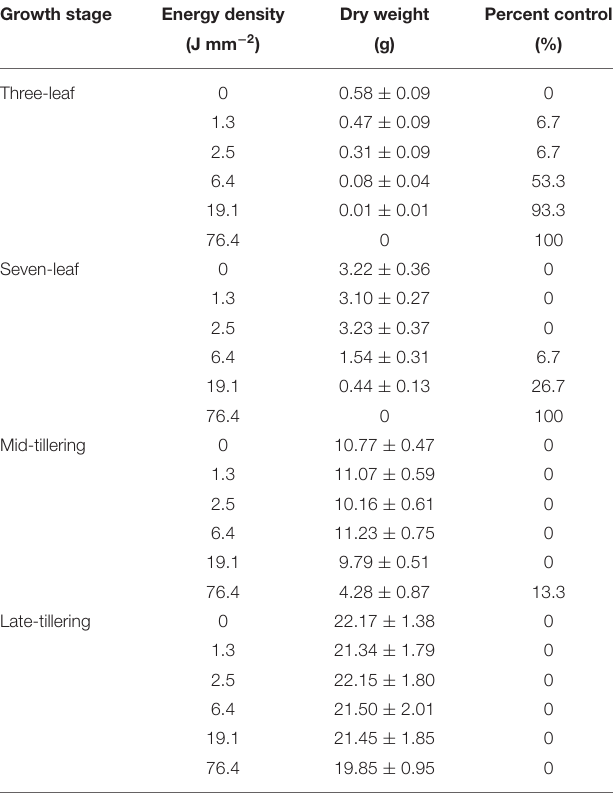
TABLE 3 | Annual ryegrass dry weight in response to increasing laser energy density treatments when applied to four different growth stages based on three trials.